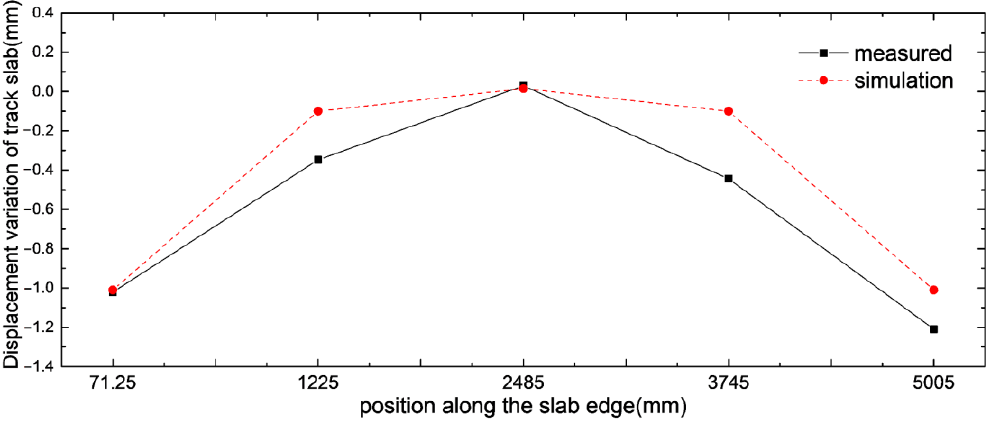
Figure 14. Comparison of measured displacement and simulation results of slab track.